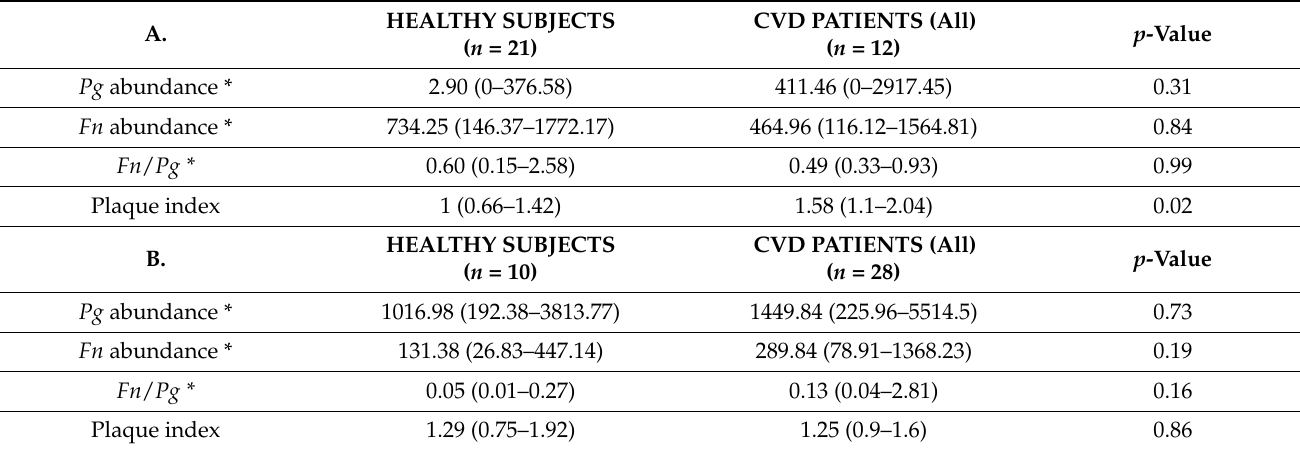
Table 3. Pg and Fn abundance: Comparison between healthy subjects and all patients with previously diagnosed CVD according to an age of less than ( A ) or equal to/greater than ( B ) 60 years.